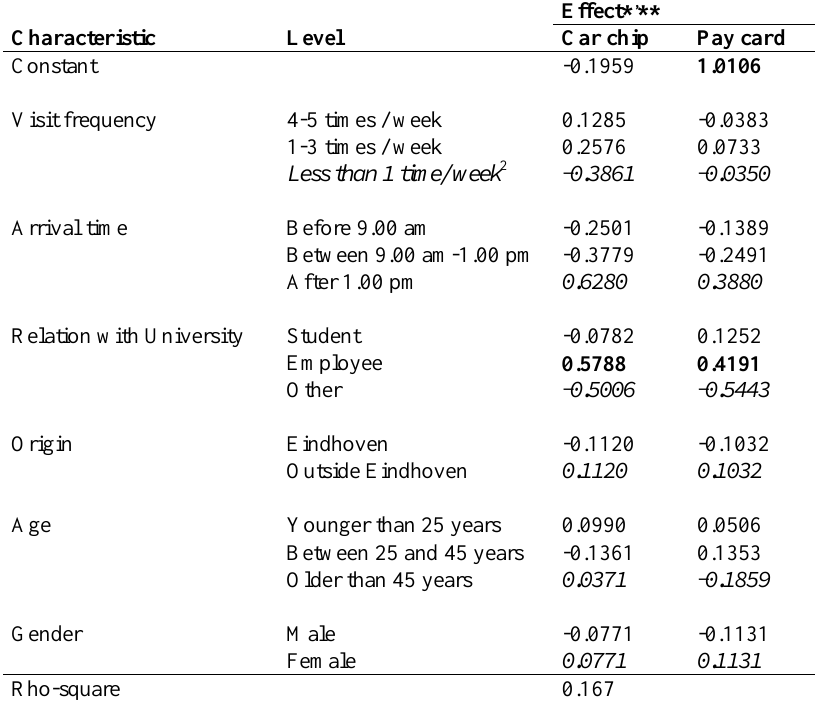
Table 7. Effects of personal characteristics on preferences for alternative means of